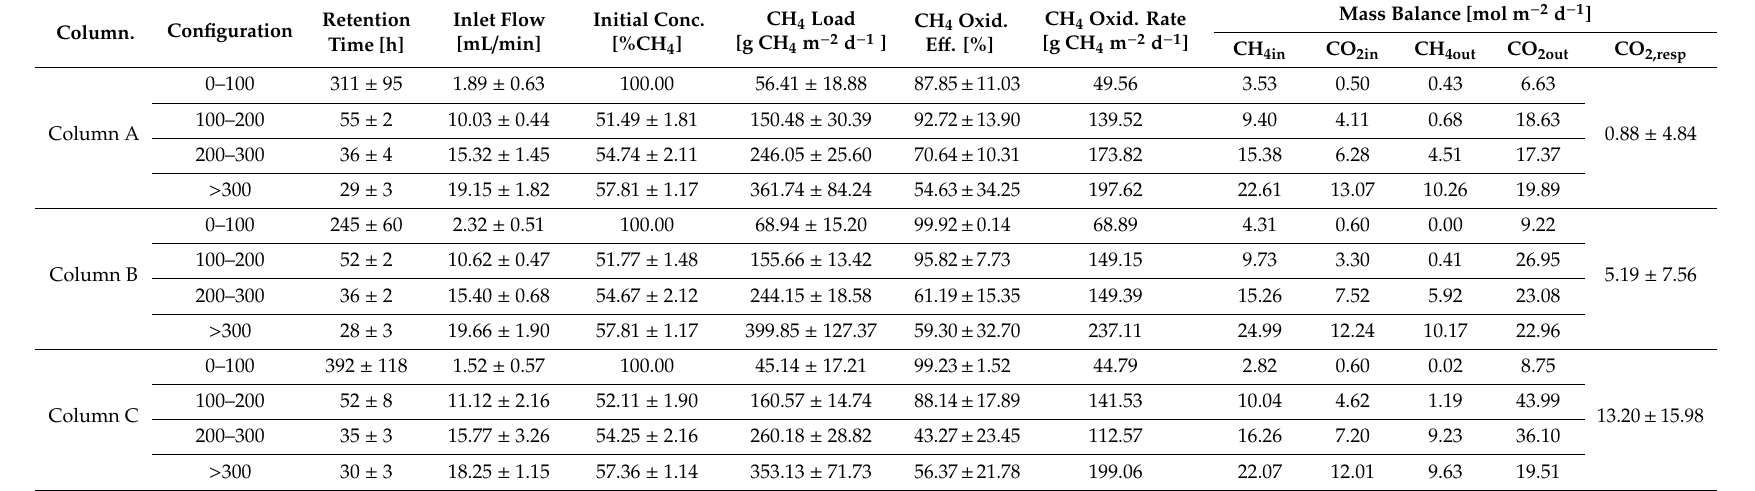
Table 2. Overview of columns setup showing configurations, average inlet flow, average retention time, average CH 4 load, average e ffi ciency, average CH 4 oxidation rate, and mass